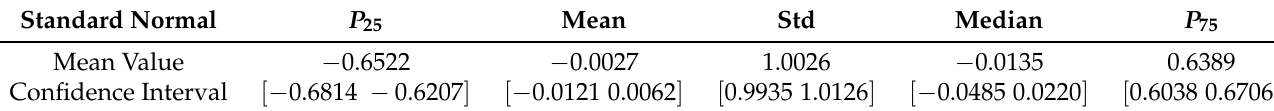
Table 2. Mean value and confidence intervals for the 2000 synthetic data collections.